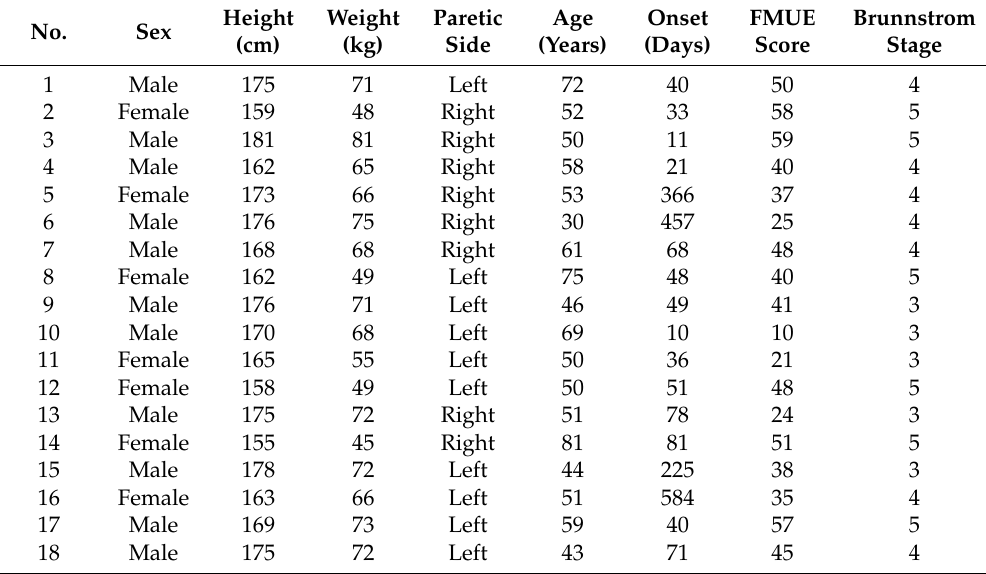
Figure 1. Schematic of the placement and orientation of the sensors in the experiment. The right upper limb is taken as an example to illustrate here. The red ones stand for EMG sensors, and the blue ones stand for IMUs. IMU’s z-axis is perpendicular outside to the plan. Table 1. Demographic information of stroke subjects.